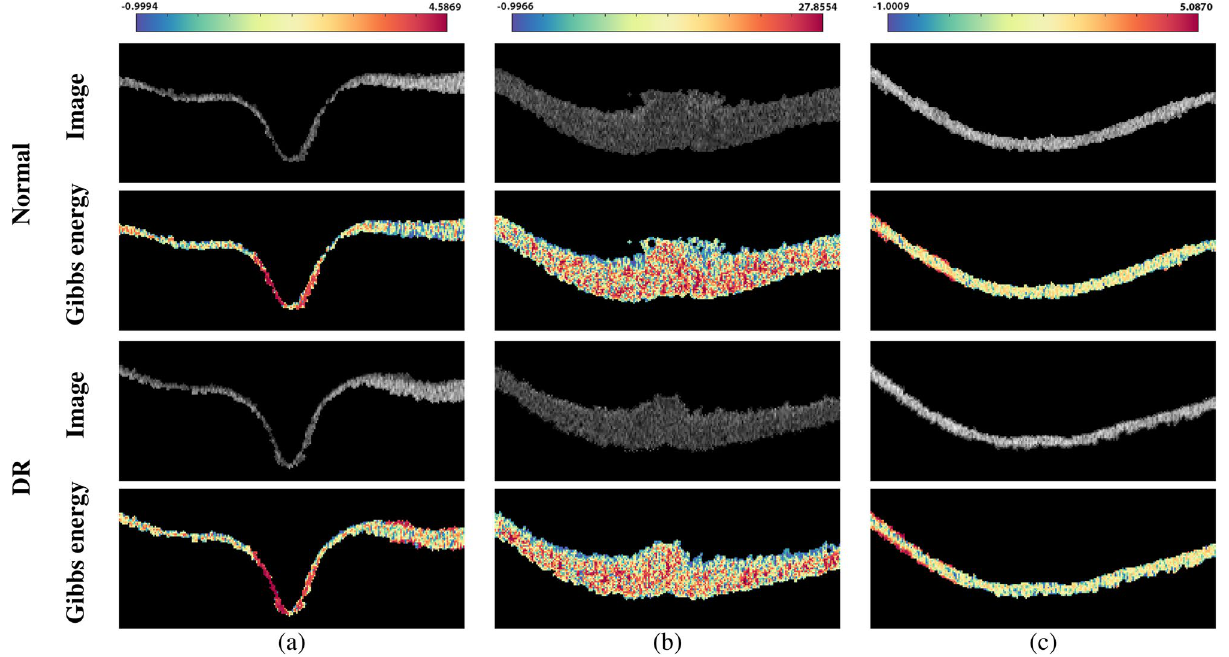
Figure 6. An illustrative color-coded example of the Gibbs energy for a normal (upper two rows) and a DR (lower two rows) case at three different layers: ( a ) NFL, ( b ) ONL, and ( c ) RPE